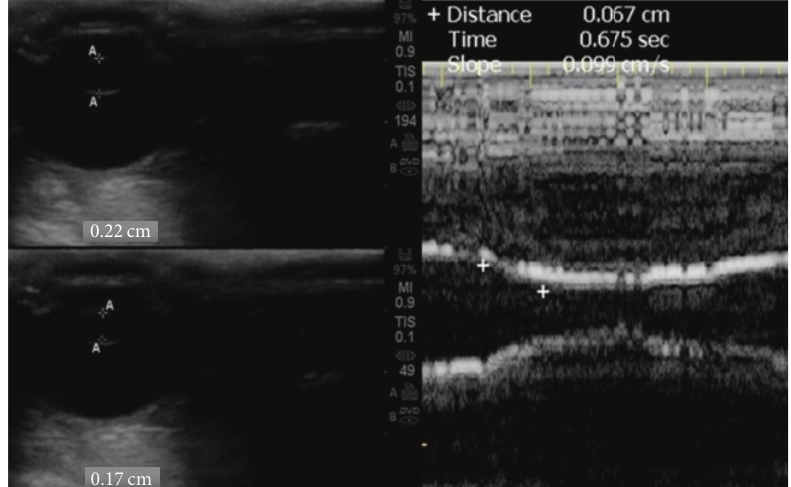
Figure 5: (Left panel) Normal pupillary size at relaxation (top) and following a consensual PLR (bottom) on B-mode. (Right panel) Normal pupil constriction velocity which is calculated by the slope of the M-mode ( 𝑉 = 0.09 cm/s in this example) as the latter can be easily placed on the pupil’s center when performing a consensual PLR (volume of autologous blood infusion = 0.1 mL, ICP = 8